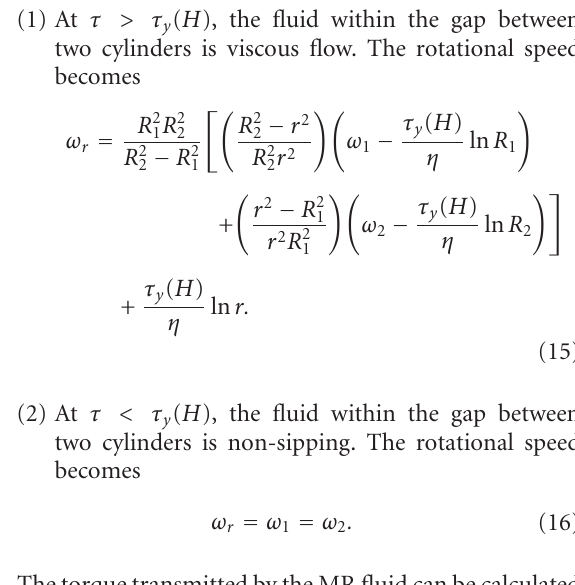
Figure 6: The output displacement versus temperature for SMA